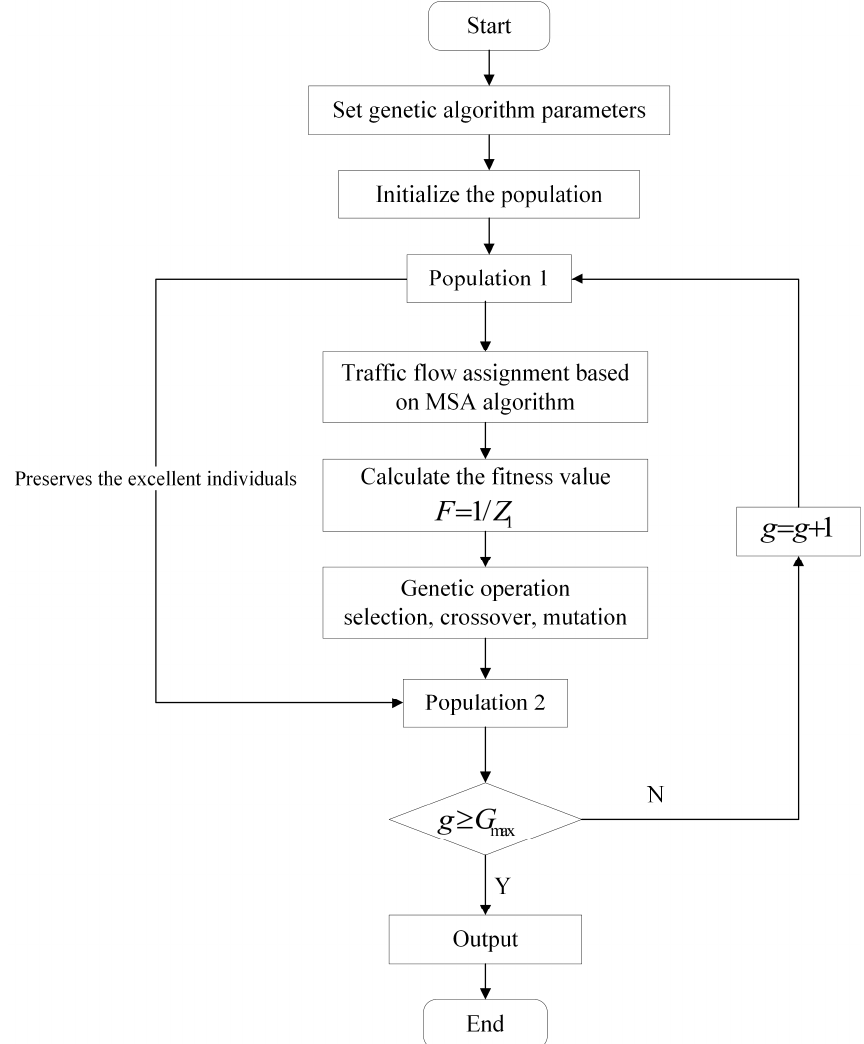
Figure 5. Algorithm flow chart.